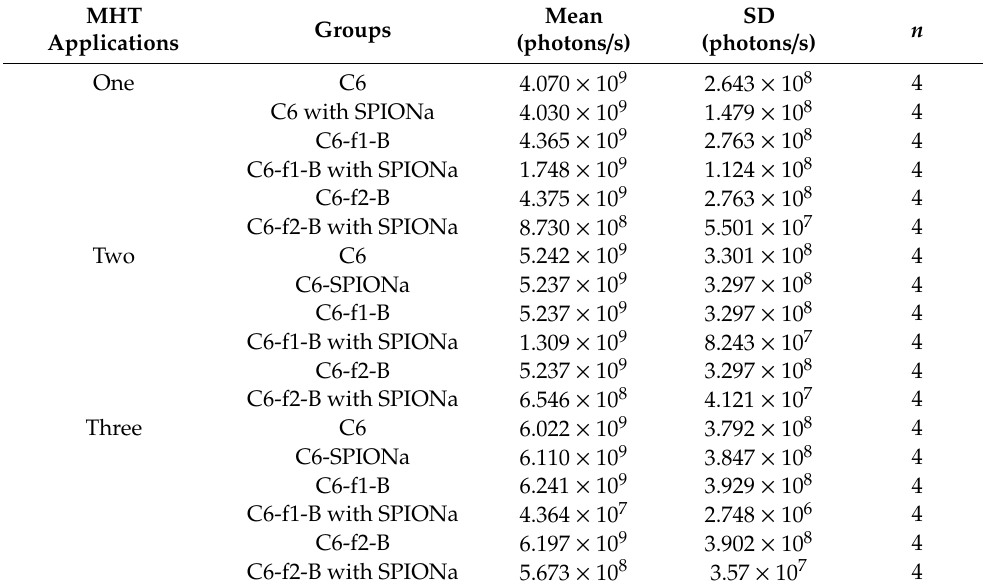
Figure 4. Evaluation of in vitro magnetic hyperthermia (MHT) therapeutic e ff ect after multiple applications of bioluminescence imaging (BLI) signal: ( A ) BLI signal intensities after one MHT application, ( B ) BLI signal intensities after two MHT applications, ( C ) BLI signal intensities after three MHT applications, and ( D ) Histogram of BLI intensities in photons / s for each experimental group after one, two, and three MHT applications. Table 3. BLI intensities values of samples submitted to in vitro MHT and their respective controls until three therapeutic